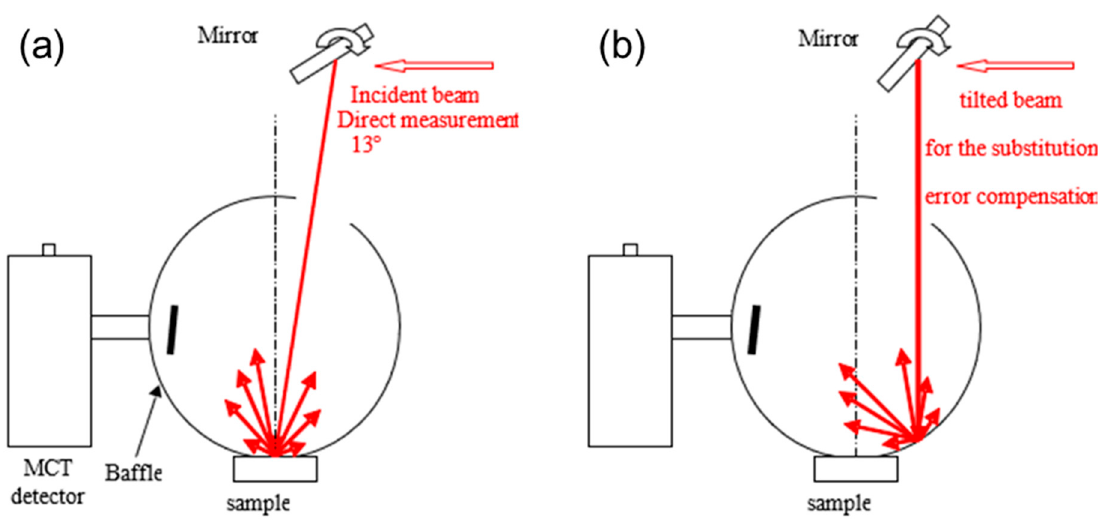
Figure A10. ( a ) Direct and ( b ) tilted beams for the compensation of the sphere substitution error at ONERA.